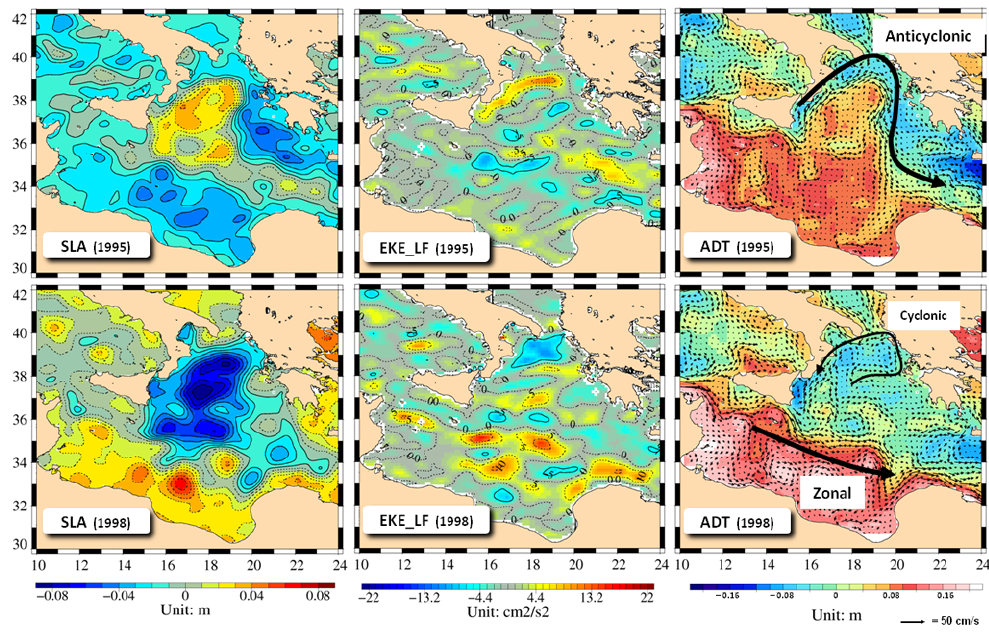
Fig. 9. Yearly averaged SLA, centered low-frequency EKE (LF-EKE) and ADT with overlaid total velocity field (left, middle and right panels, respectively) in the Ionian region during year 1995 (top panels) and year 1998 (bottom panels). Units respectively in m, cm 2 s − 2 and m. Vector field scale: 50cms − 1